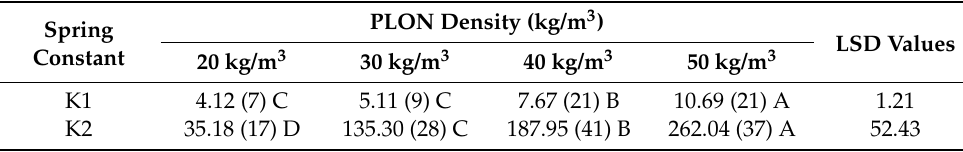
Table 2. Mean K Values of the four PLON Densities Evaluated in this Study.